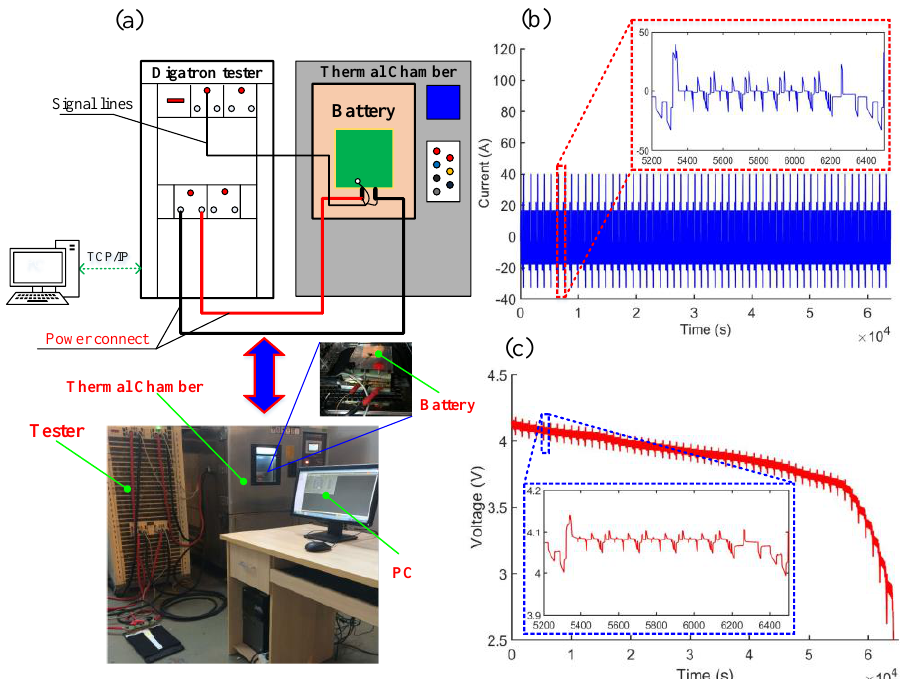
Figure 3. Experimental equipment and results. ( a ) Schematic of the cell test system; ( b ) Measured current under European Driving Cycle (NEDC) working condition; ( c ) Measured voltage under NEDC working condition.